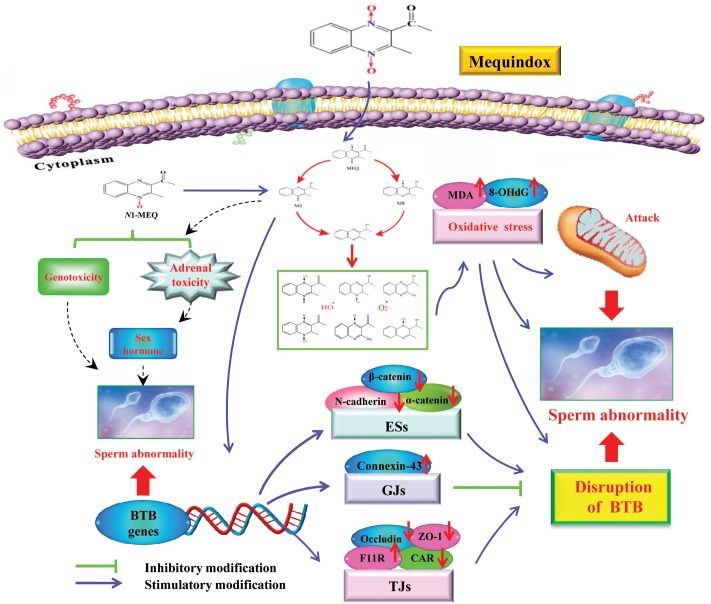
The proposed mechanisms of reproductive toxicity in mouse caused by MEQ. The oxidative damage occurs via reduction of the N→O group of MEQ, which causes mitochondrial dysfunction and sperm abnormality. M4 passed through the BTB with a disruptive effect on BTB via alteration of the related genes (e.g., TGs, GJs and basal ESs). The disrupted BTB further resulted in the invasion of M4 into the testes to exert the toxic effect on the mitochondria and spermatogenic cells. The adrenal toxicity and genotoxicity caused by N1-MEQ, may contribute to sperm abnormalities.